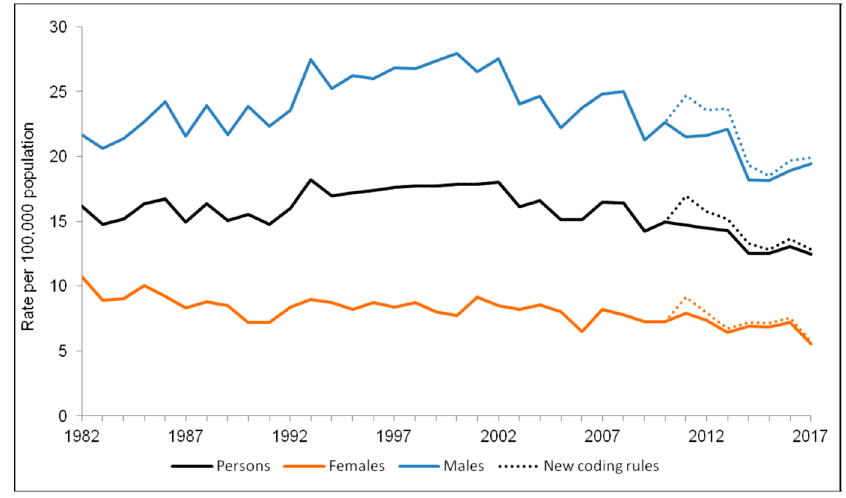
Figure 1. Standardized rate of ‘probable suicide’ in Scotland, 1982–2017. 2